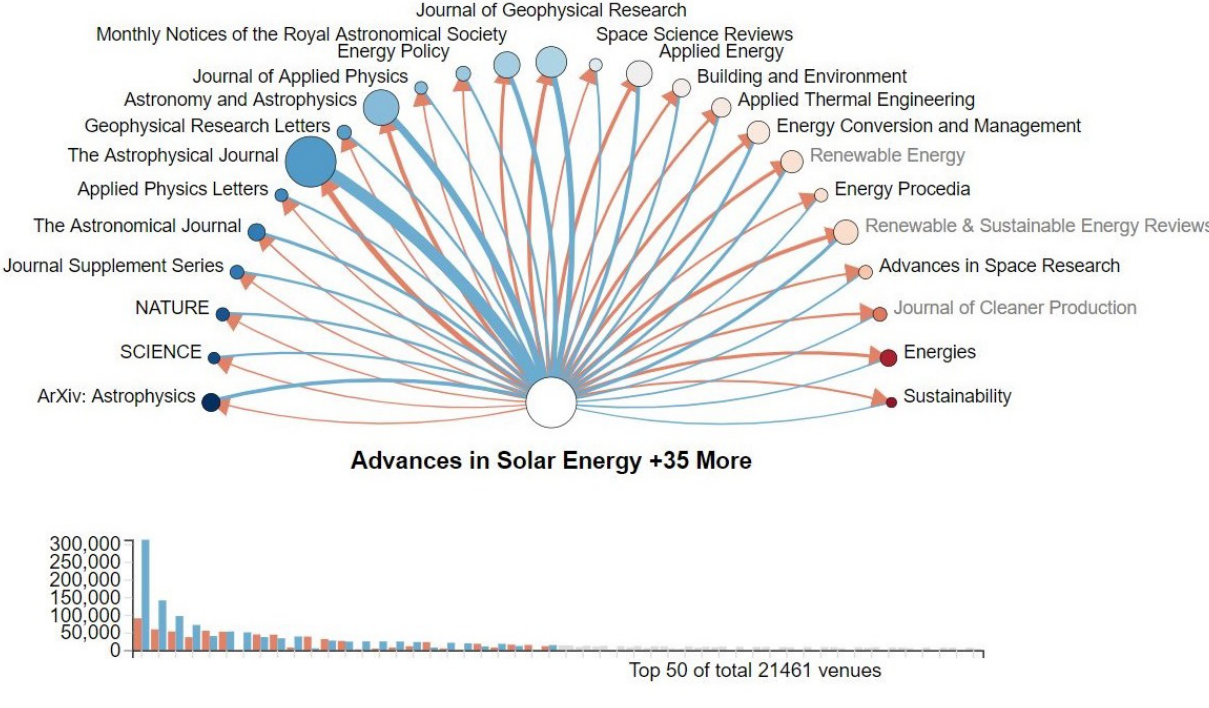
Figure 7. Influence flower visualizes publications and citations connections between